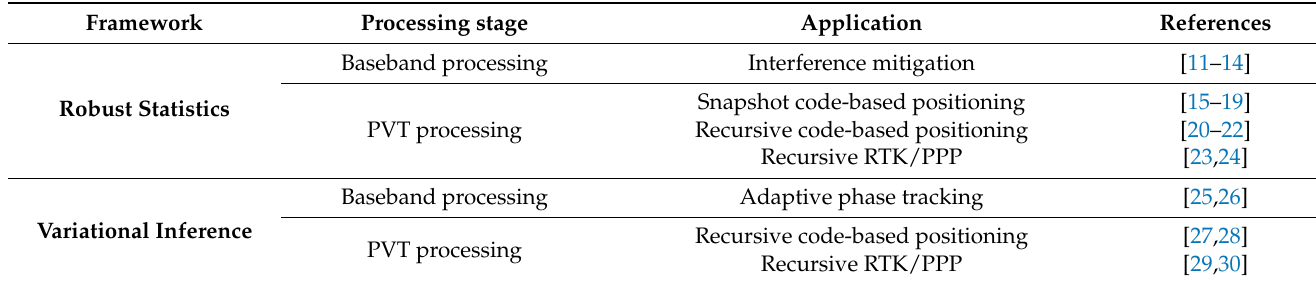
Table 1. Overview on robust estimation for global navigation satellite system (GNSS)